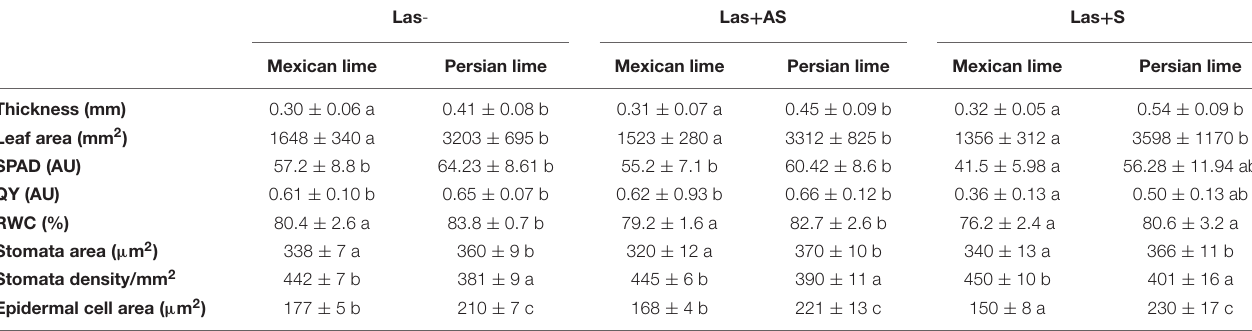
TABLE 2 | Leaf physiological characterization of Mexican and Persian